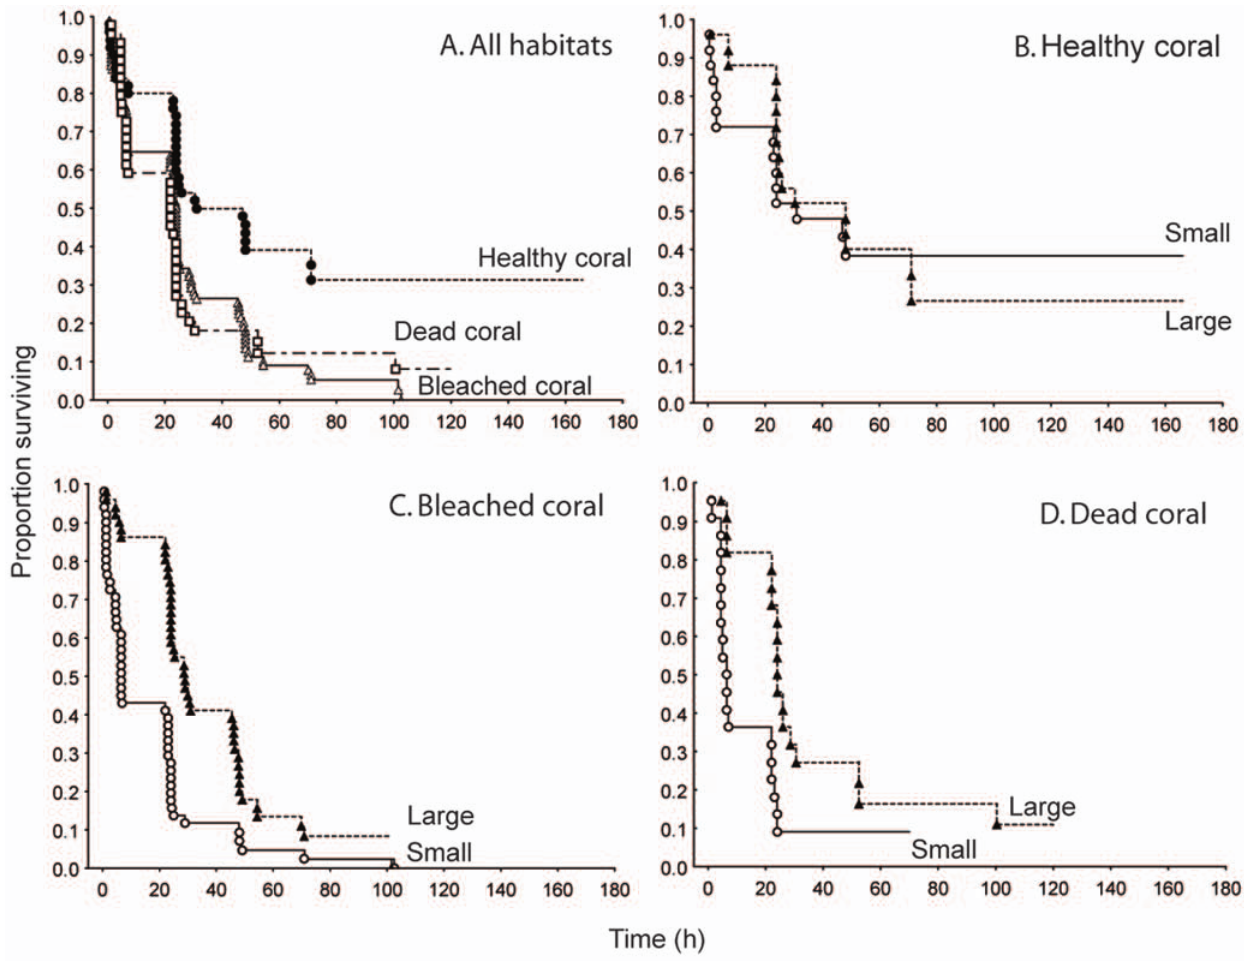
Figure 3. Comparison of fish size-specific survival on 3 coral habitats. Survival trajectories of Pomacentrus amboinensis regardless of size on three habitats ( A ), and then of large (triangles) and small (circles) fish that were settled onto ( B ) healthy live coral, ( C ) thermally bleached coral, and ( D ) dead coral.